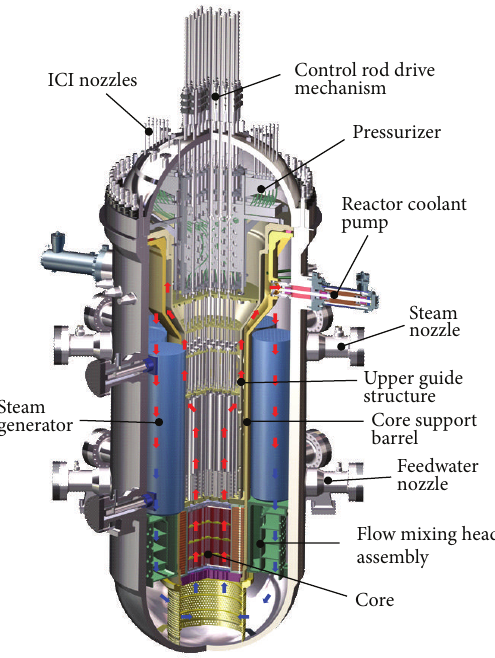
Figure 1: SMART reactor vessel assembly.